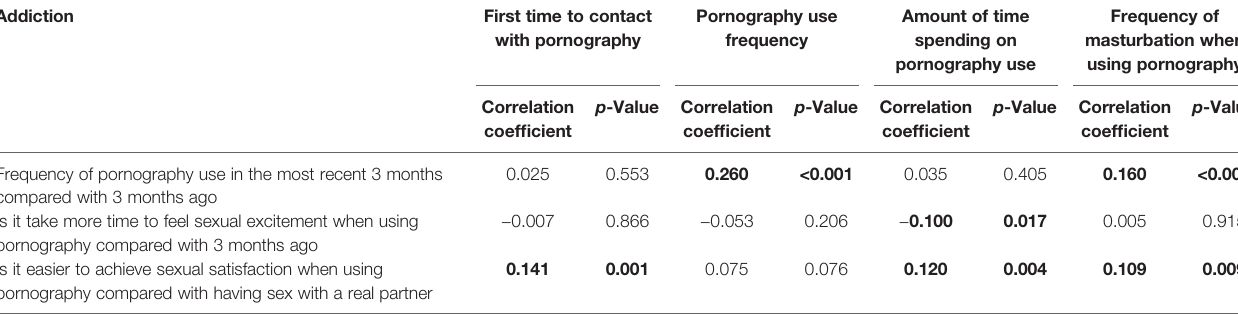
TABLE 3 | Associations between pornography use and the addiction possibility for pornography use. Addiction